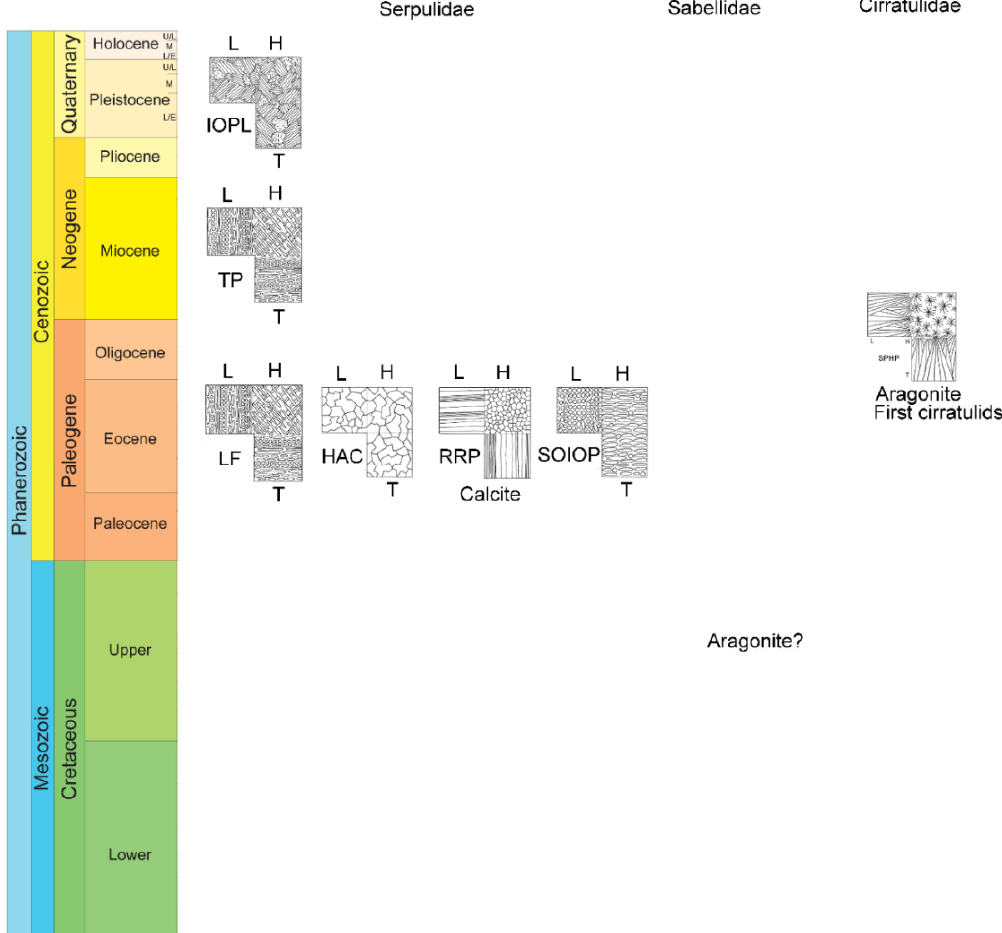
Figure 4. First appearances of tube microstructures and mineral composition in calcareous polychaetes (Cretaceous to Quaternary). IOP—irregularly oriented prismatic structure, SPHP—Spherulitic prismatic structure, SP—simple prismatic structure, LF—lamello-firbrillar structure, HAC—Homogeneous angular crystal structure, RRP–Regularly ridged prismatic structure, TP—twisted plywood structure, SOIOP—semi-ordered irregularly oriented prismatic structure, IOPL—irregularly oriented platy structure. Stratigraphy modified based on the International Stratigraphic Chart [28].